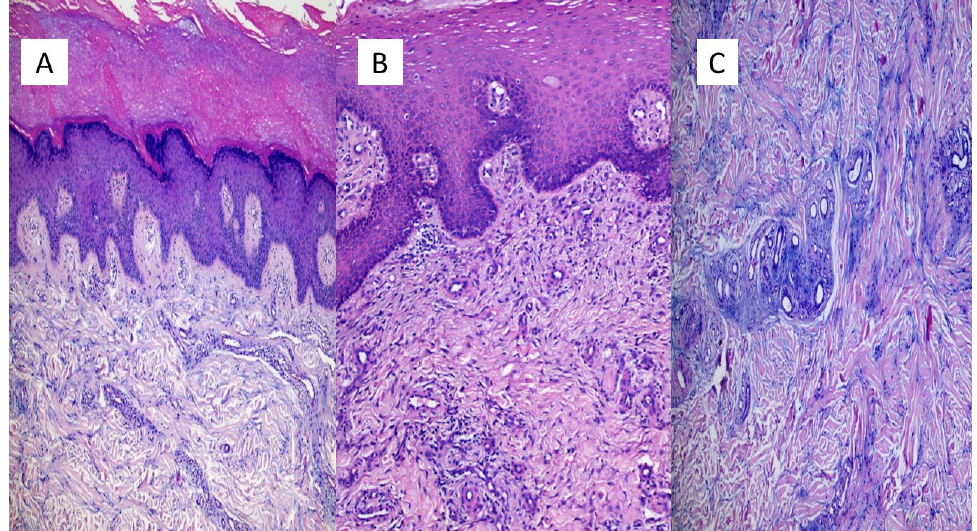
Figure 2. ( A ) Example of an erythema-multiforme like lesion of the first group of patients. In ( A ), we note the presence of modest ortho-parakeratosis (sampling from the pre-auricular area), with acanthosis and a mild inflammatory lymphomonocytic infiltrate (Hematoxylin-Eosin, Original Magnification: 4 ×. ( B ) Histological examination revealed a modest inflammatory infiltrate mainly peri-vasally, in the superficial and middle dermis (sample taken from the back) (Hematoxylin-Eosin, Original Magnification: 10 ×); ( C ) Histological details of the dermal edema and mucinosis of the hair appendages (Hematoxylin-Eosin, Original Magnification: 20 ×).